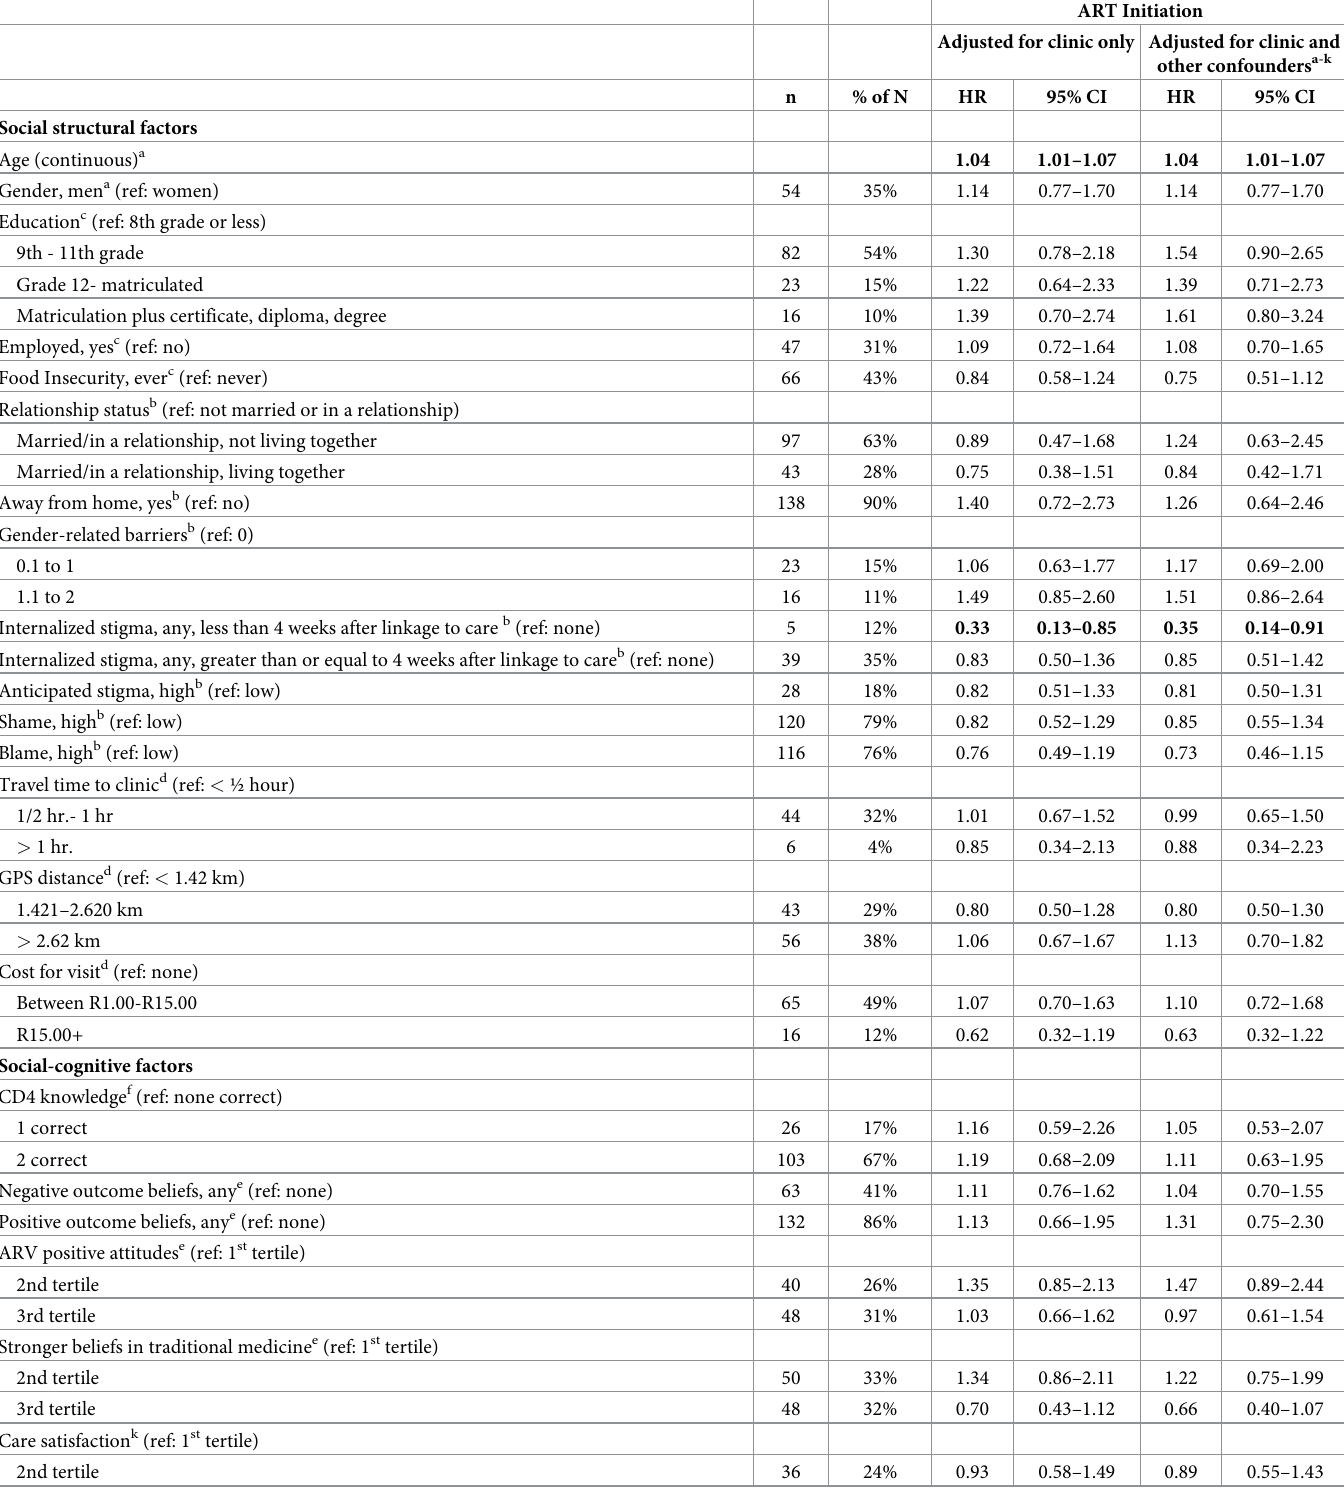
Table 2. Hazard ratios (HR) for hypothesized predictors of time to ART initiation (clinic-adjusted and adjusted for confounders) (N = 153).